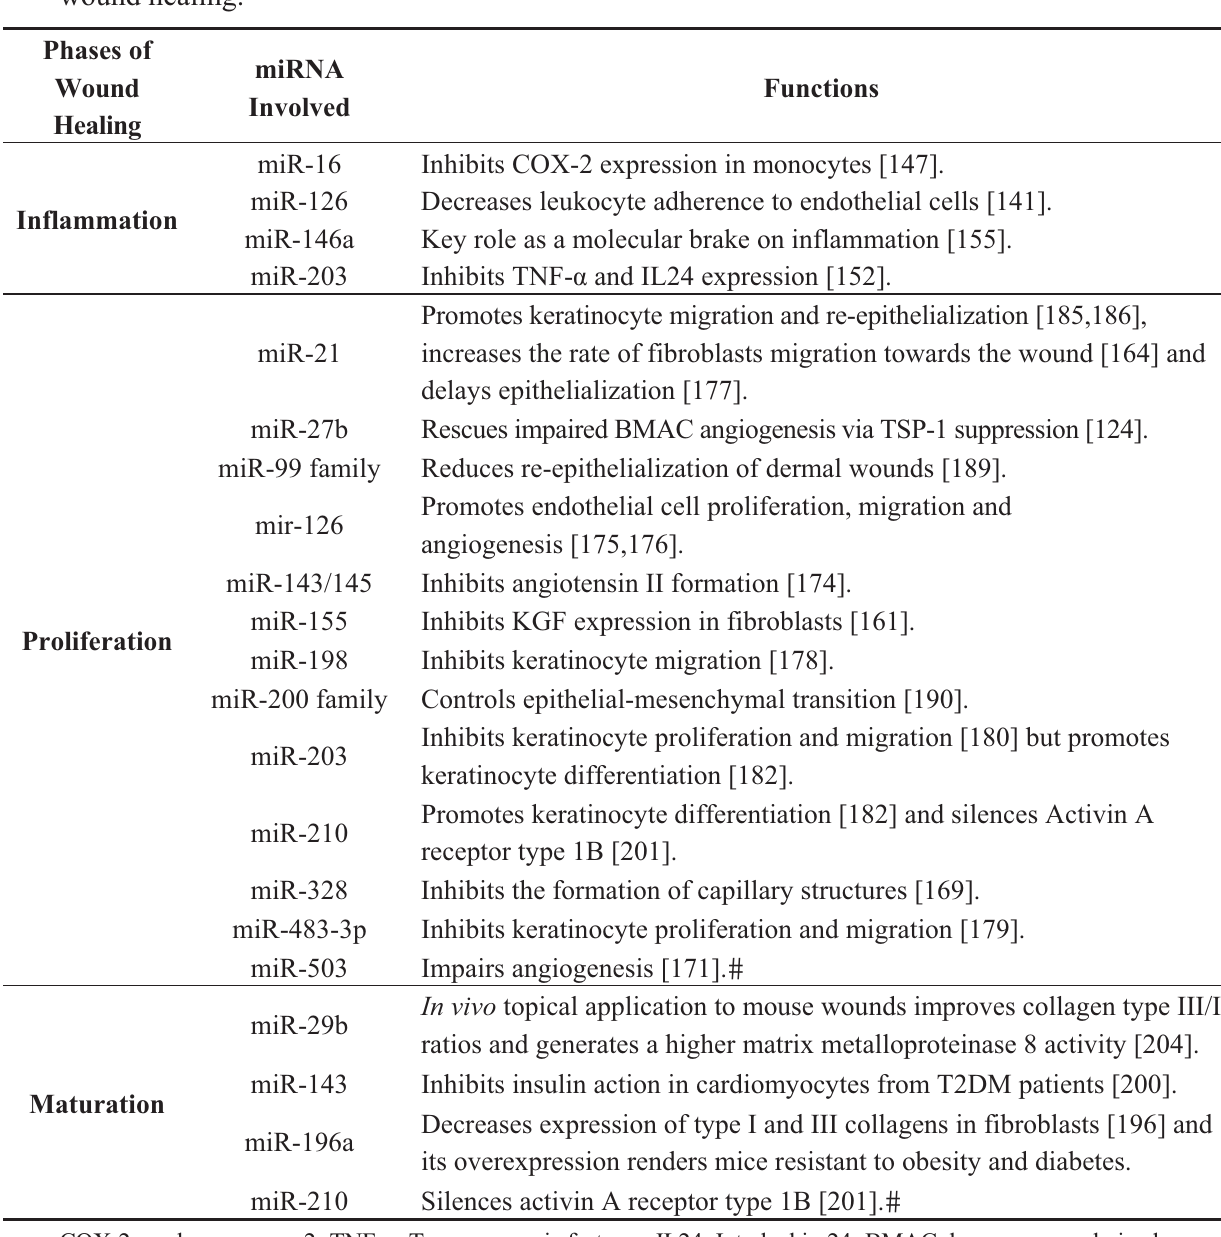
Table 2. Summary of the most relevant miRNAs involved in the different phases of wound